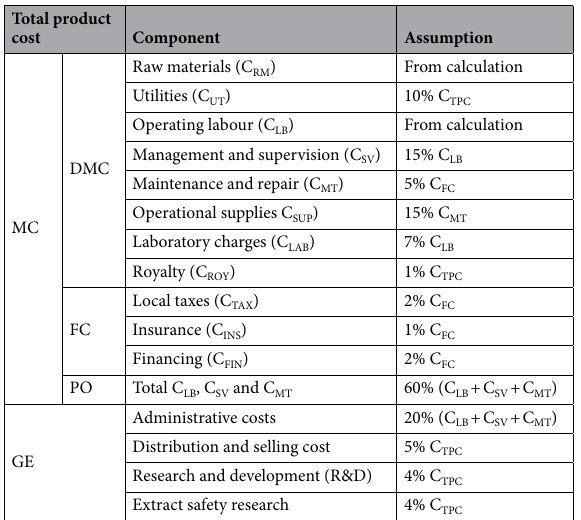
Table 7. Assumption factor for components in total product cost. MC Manufacturing cost, DMC Direct manufacturing cost, FC Fixed charges, PO Plant overhead, GE General expenses, C TPC Total product cost, C FC Fixed capital